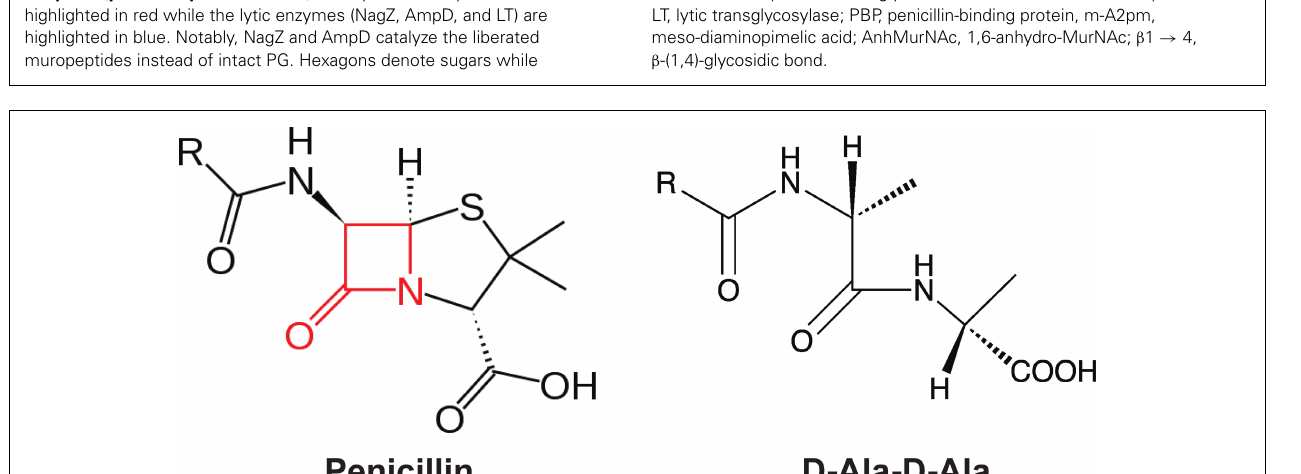
rectangles denote stem amino acids.The cross-linkage ( ) between the top and bottom glycan strands is D-Ala → meso-A2pm. LT, lytic transglycosylase; PBP, penicillin-binding protein, m-A2pm,